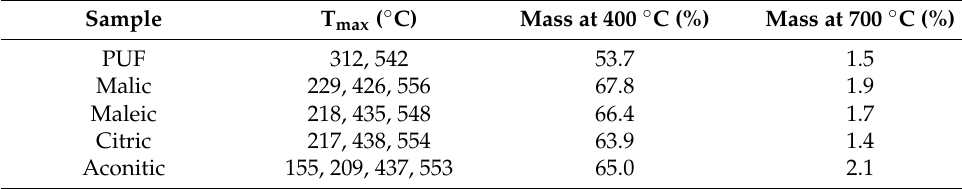
Figure 4. Thermogravimetric analysis ( a ) and derivative thermogravimetric ( b ) curves for PUF and NIPU foams under air. Table 1. Thermogravimetric data for foam samples in oxidative environment.